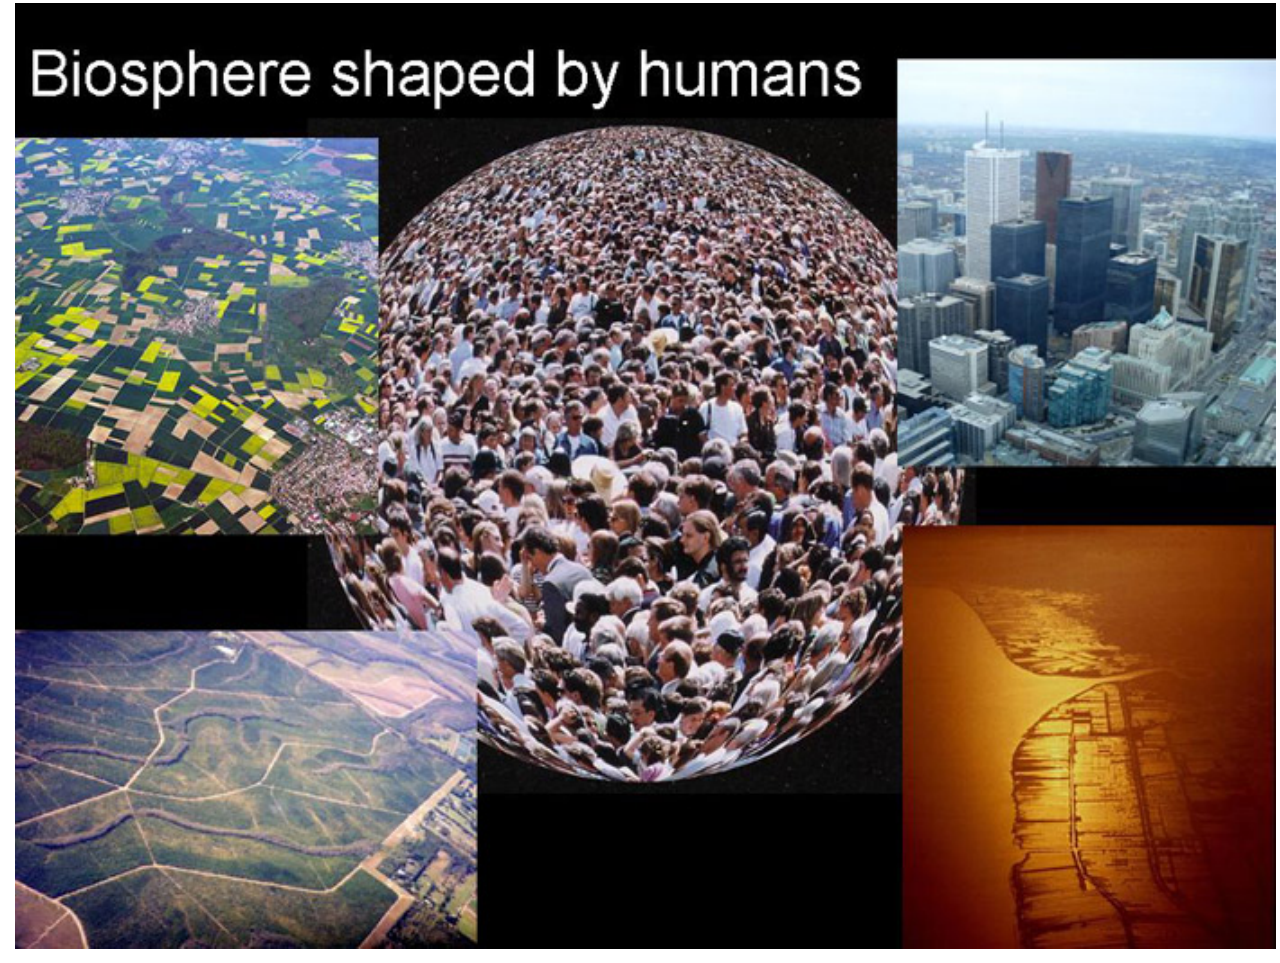
Fig. 1 . A biosphere shaped by humans. Human actions continue to alter environments up to the scale of the planet, yet societal development, human well-being, and collective welfare depend on the capacity of these environments to be sustained. Bottom right photo used with permission from Nils